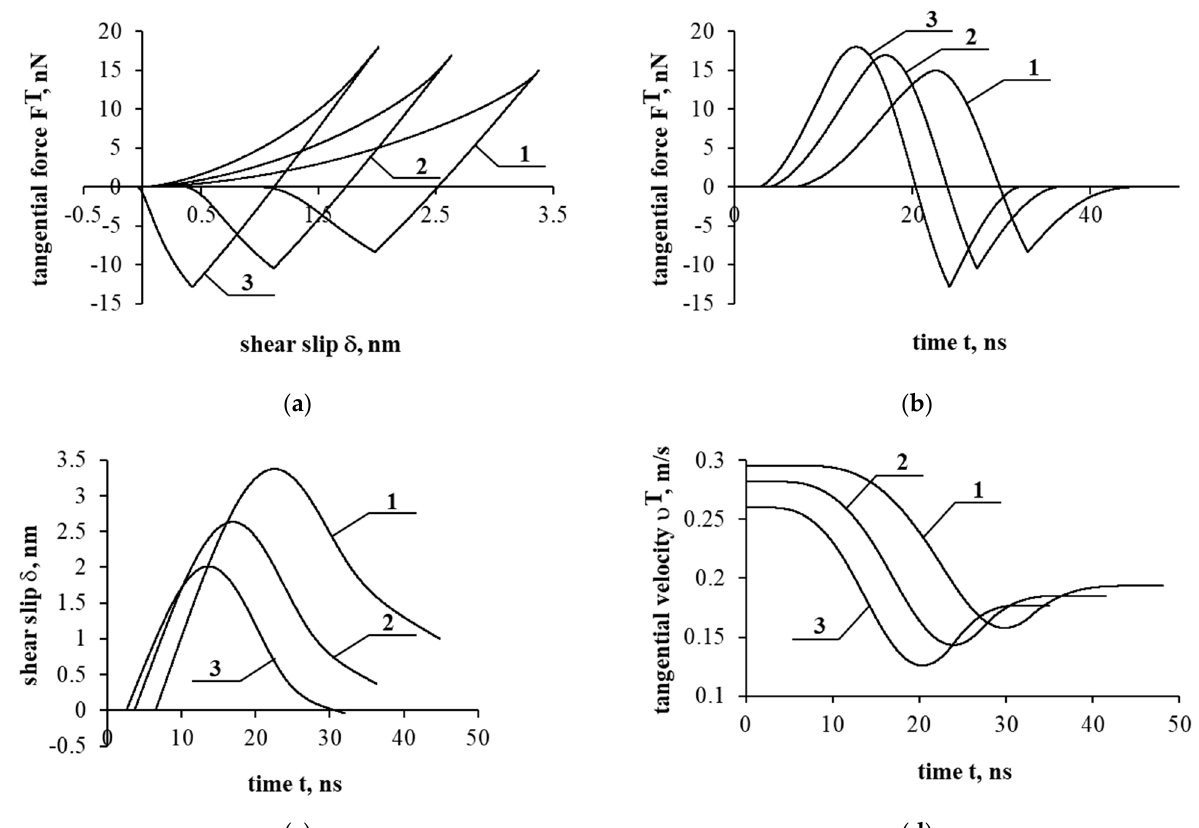
Figure 7. Normal interaction. Particle impact at various impact angles: 1— 𝜑 (cid:2868),(cid:2869) = 10  ; 2— 𝜑 (cid:2868),(cid:2870) = 20  ; 3— 𝜑 (cid:2868),(cid:2871) = 30  . Normal force versus displacement ( a – c ); normal force ( d ); normal displacement ( e ); normal velocity history ( f ).